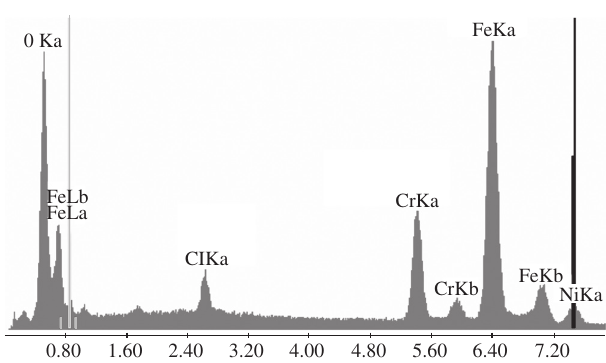
Figura 6. Energy dispersive X ray (EDX) analysis of the AISI 304 steel sample heat treated at 300